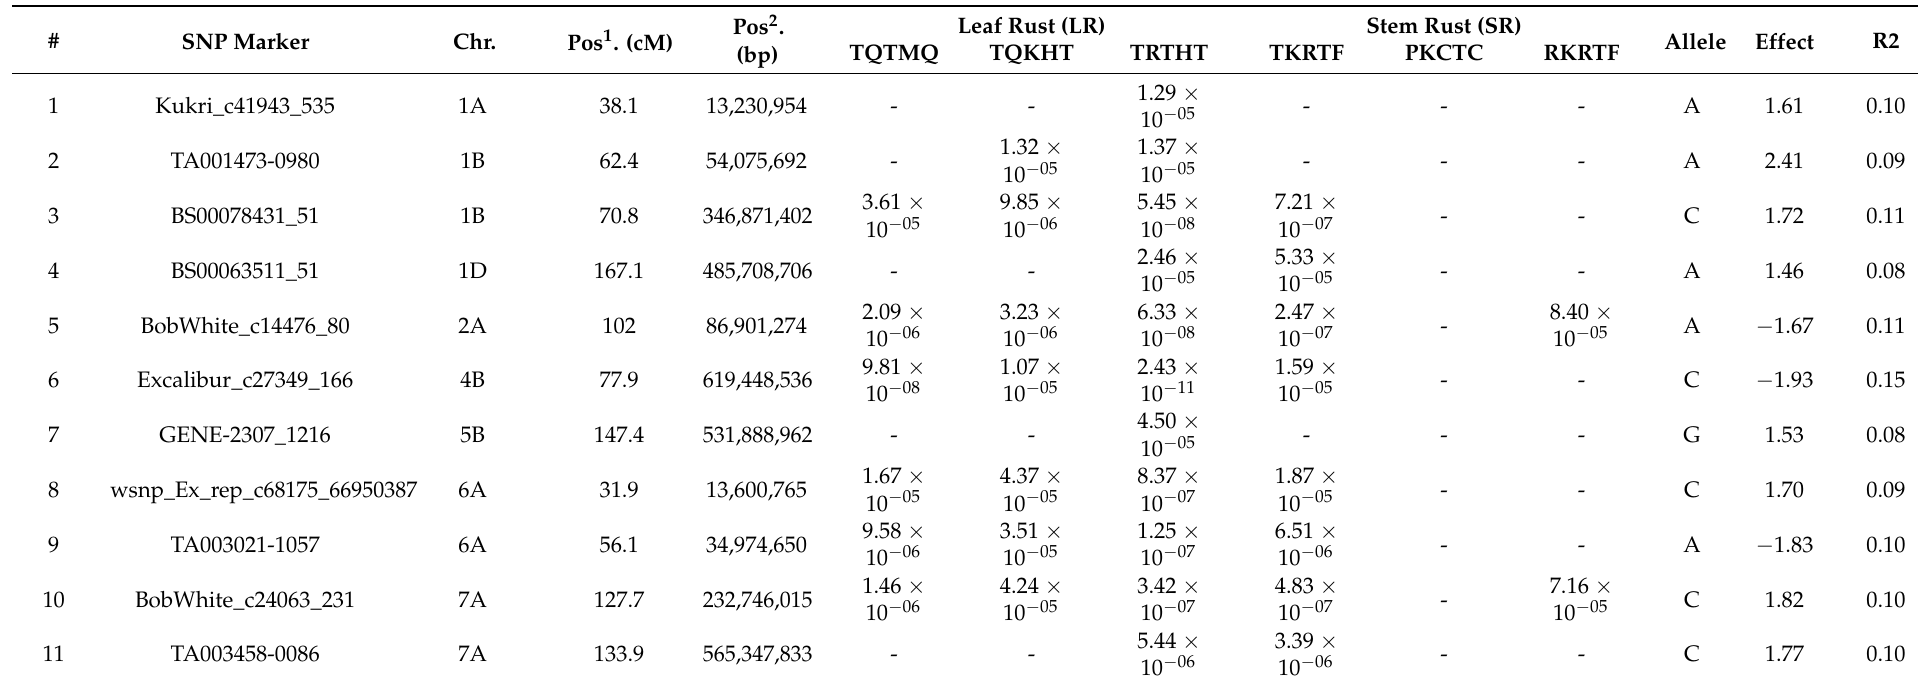
Table 3. List of quantitative trait loci (QTLs) for race-specific seedling resistance to leaf rust (LR) and stem rust